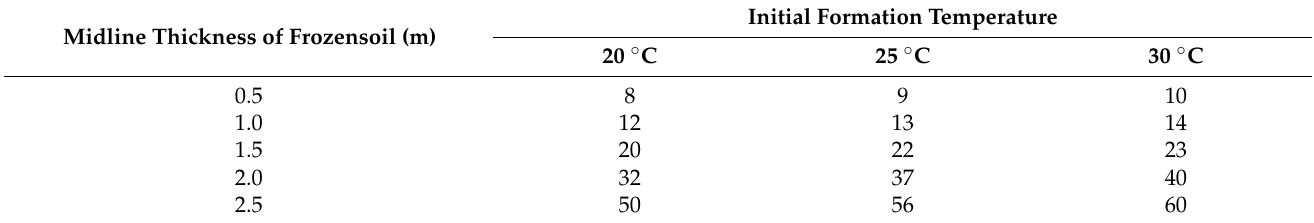
Table 8. Freezing duration of the frozen soil thickness midline at different initial temperatures (day).